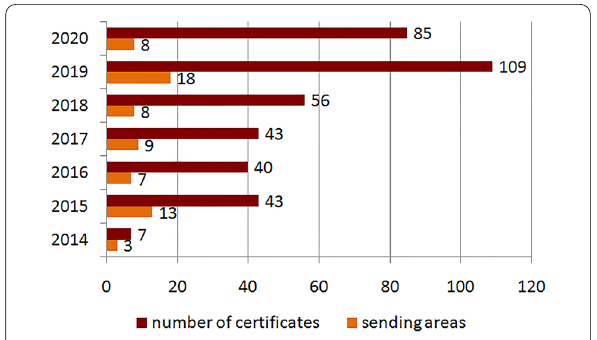
Fig. 1 Number of certificates and number of sending areas per year of annotation